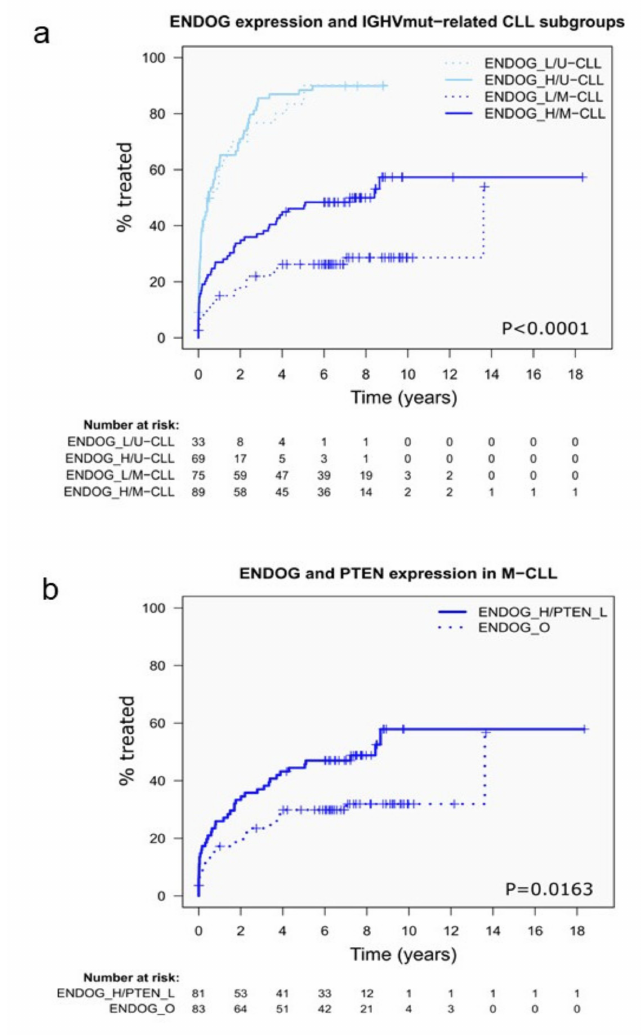
Figure 5. Time to first treatment (TTT) cumulative curves according to ENDOG expression in subgroups of CLL patients and their dependency on PTEN expression levels. ( a ) CLL patients with high (H) ENDOG expression levels showed a significantly shorter TTT compared to those with low (L) ENDOG expression levels, but only in the M-CLL subgroups between the categories defined by IGHV mutational status. ( b ) ENDOG expression association with a significantly shorter TTT in the M-CLL subgroup was only detected in cases with concomitant low PTEN expression levels compared to the other combinations of ENDOG and PTEN expression categories